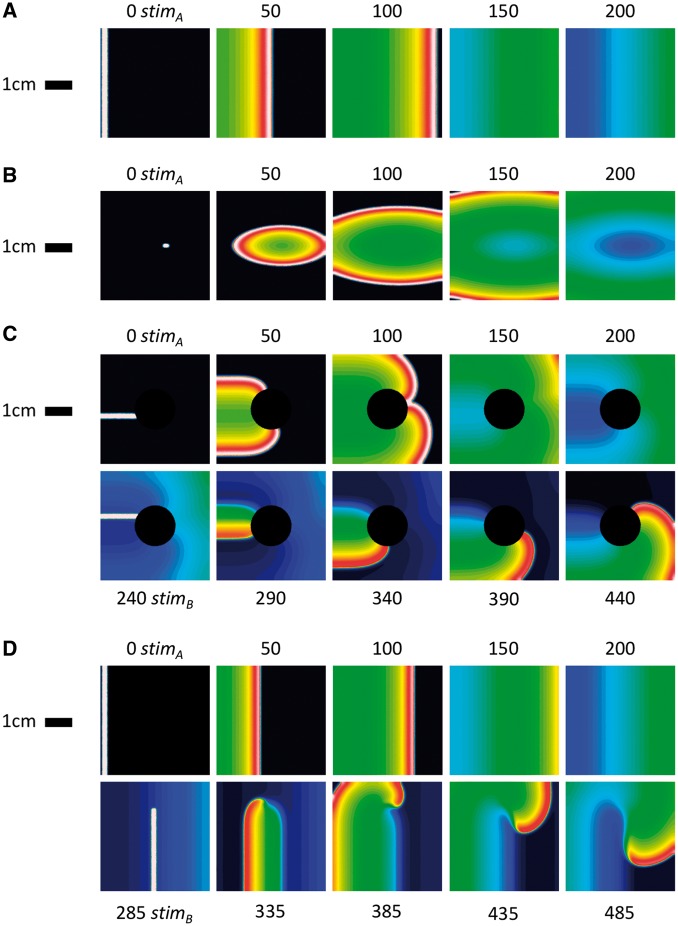
Initiation of activation patterns in the atrial monolayer. (A) Linear activation; (B) focal activation; (C) re-entrant activation; and (D) spiral wave activation. Stimulated regions are shown in white in the left-most column of each row.